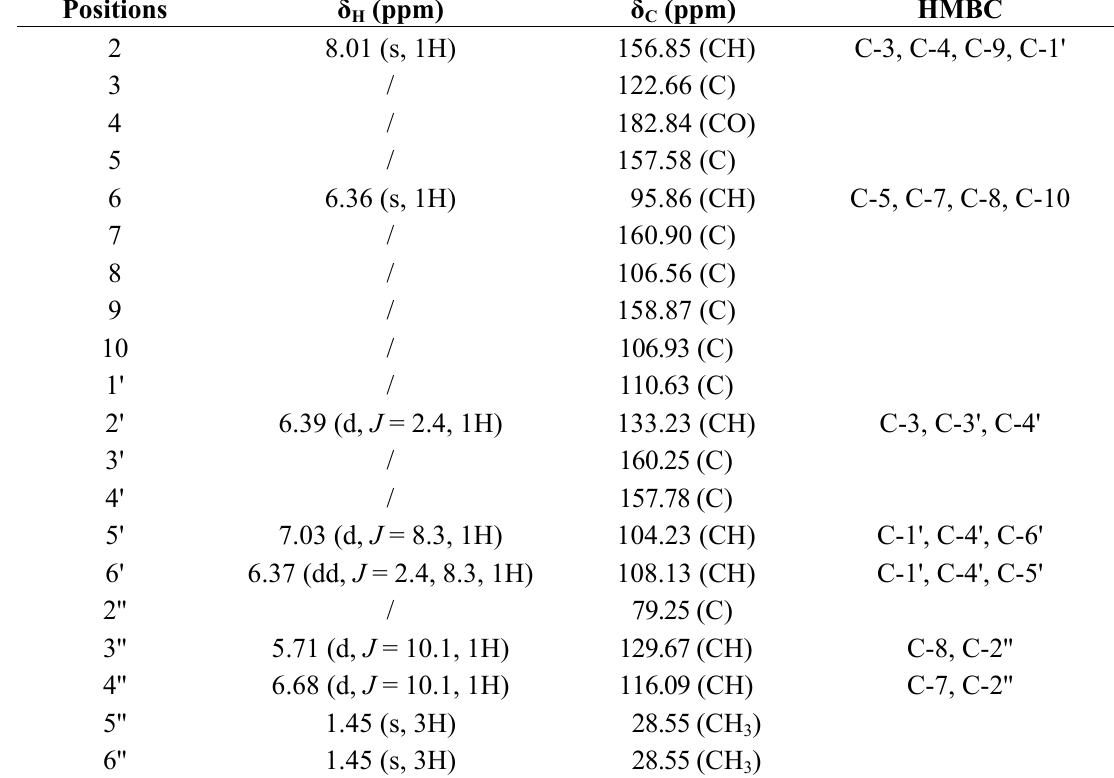
Table 1. The 1 H and 13 C-NMR chemical shifts of compound 1 in CD